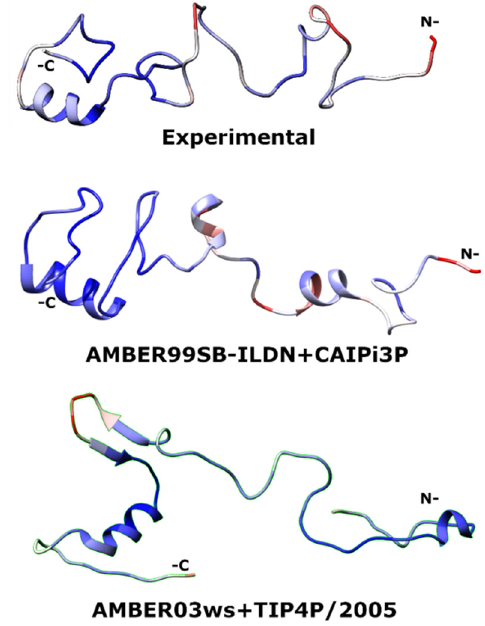
Figure 7. Average structures for the At2g23090. Highly flexible regions (high per-residue RMSF) are coloured red, while more rigid regions with lower per-residue RMSF are coloured blue.